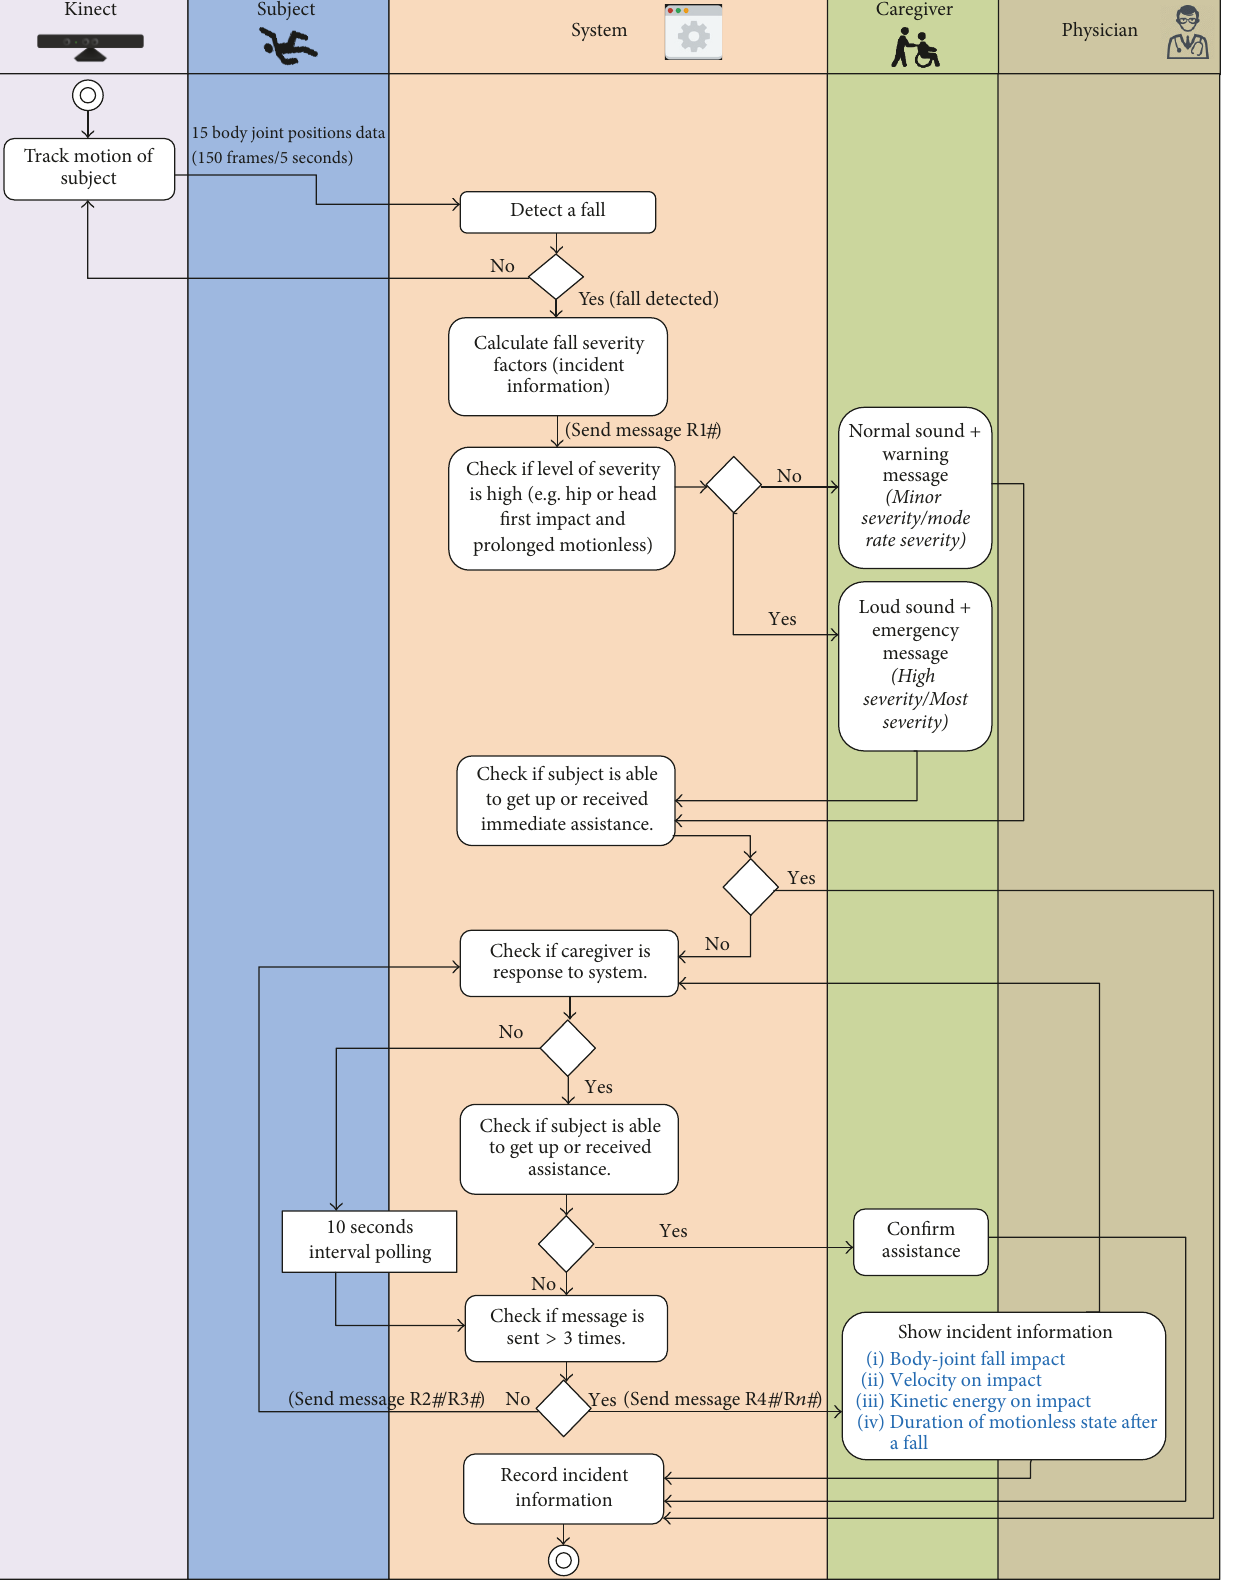
Figure 7: Process flow for message